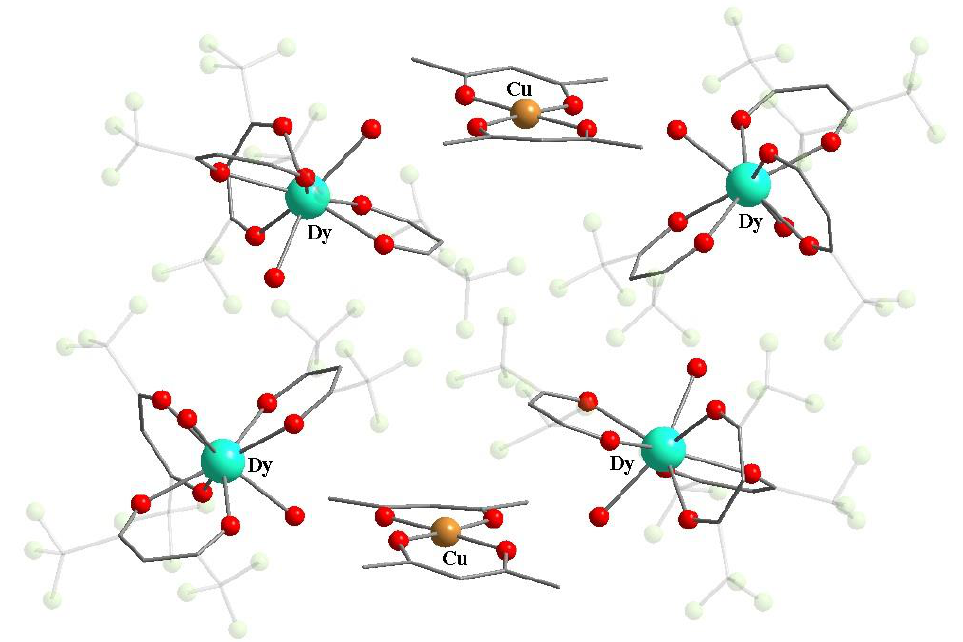
Figure 22. A crystal packing fragment of 43 [90]. Hydrogen atoms have been omitted, some ligand groups are transparent for clarity. The cif has been retrieved from CCDC. CCDC number is 1938913. The solid-state redox reaction between tin(II) and 3d metal β -diketonates proceeded with the ligand exchange around the metal centers to give the heterometallic compounds 44 – 46 (Scheme 17) [91]. The obtained bimetallic complexes consisted of two homoleptic tris - β -diketonate fragments forming an ion pair (Figure 23).